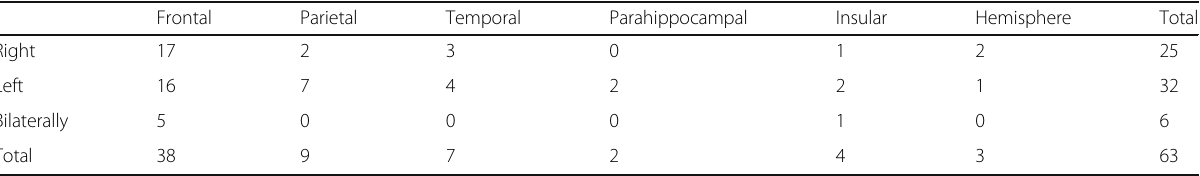
Table 4 FCD anatomic